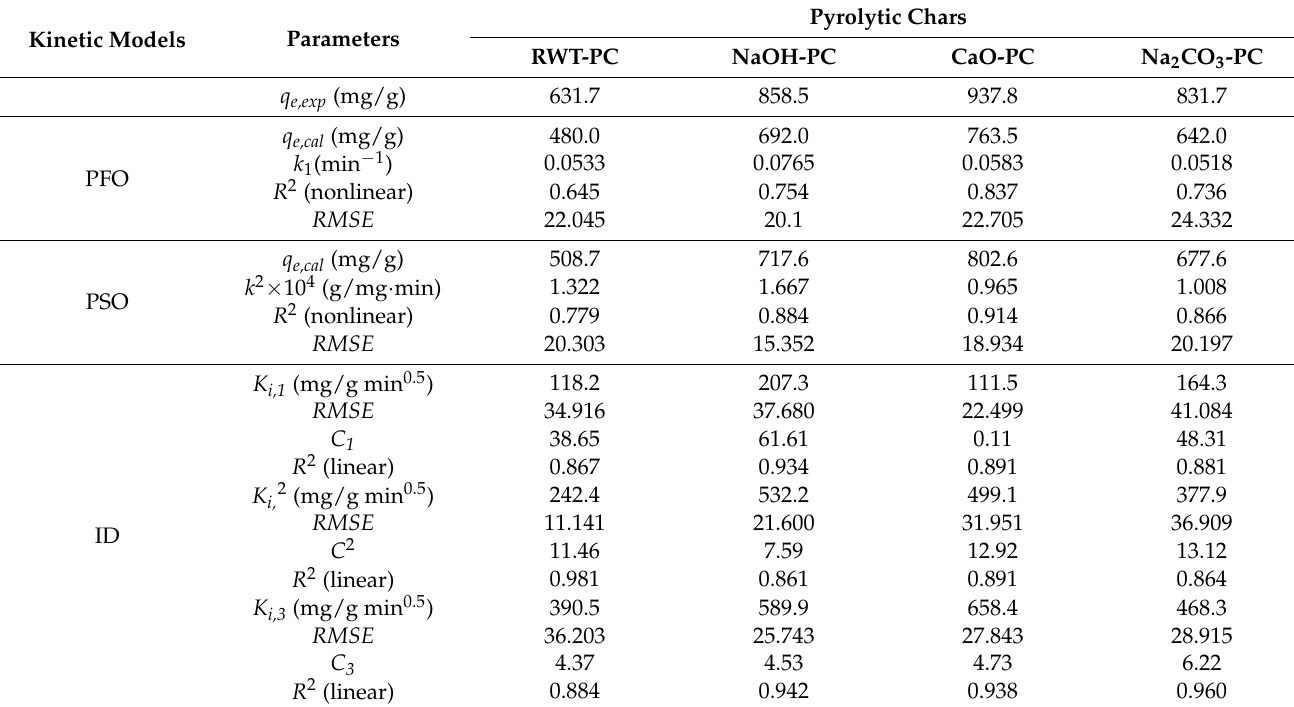
Table 4. Kinetic parameters of MG adsorption on PCs derived from waste tire.